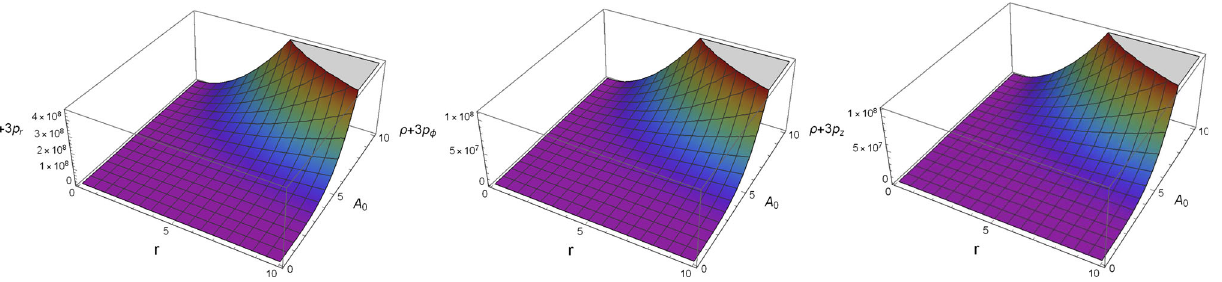
Fig. 6 The variation of (ρ + p r ) (MeV/fm 3 ) , (ρ + p φ ) (MeV/fm 3 ) and (ρ + p z ) (MeV/fm 3 ) w.r.t r (km) with m = n = 1 is shown in this panel. CASE